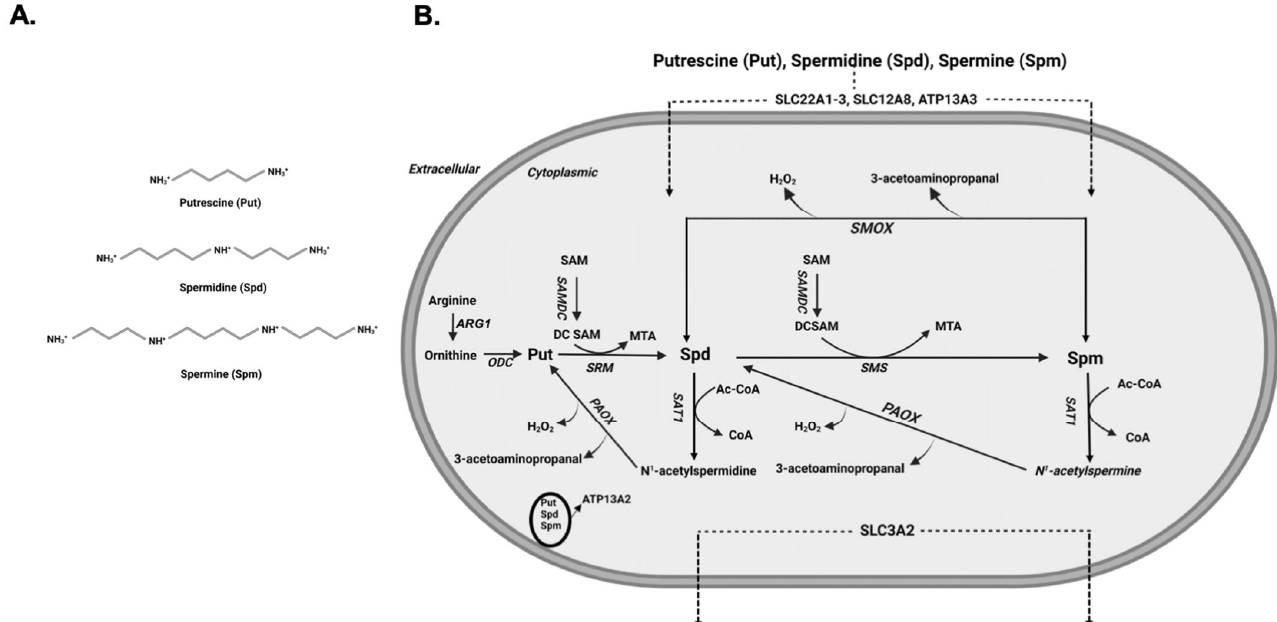
Figure 1. Polyamine molecular structure and polyamine regulation. ( A ) Chemical structure of Put, Spd and Spm. In physiological pH all three molecules are positively charged. ( B ) Schematic depiction of polyamine metabolic pathway and polyamine transporters. Arginase 1 (ARG1), Ornithine decarboxylase (ODC), SAM decarboxylase (SAMDC), Spermidine synthase (SRM), Spermine synthase (SMS), Spermidine/Spermine N1-acetyltransferase (SAT1), acetylpolyamine oxidase (PAOX) and Spermine oxidase (SMOX).